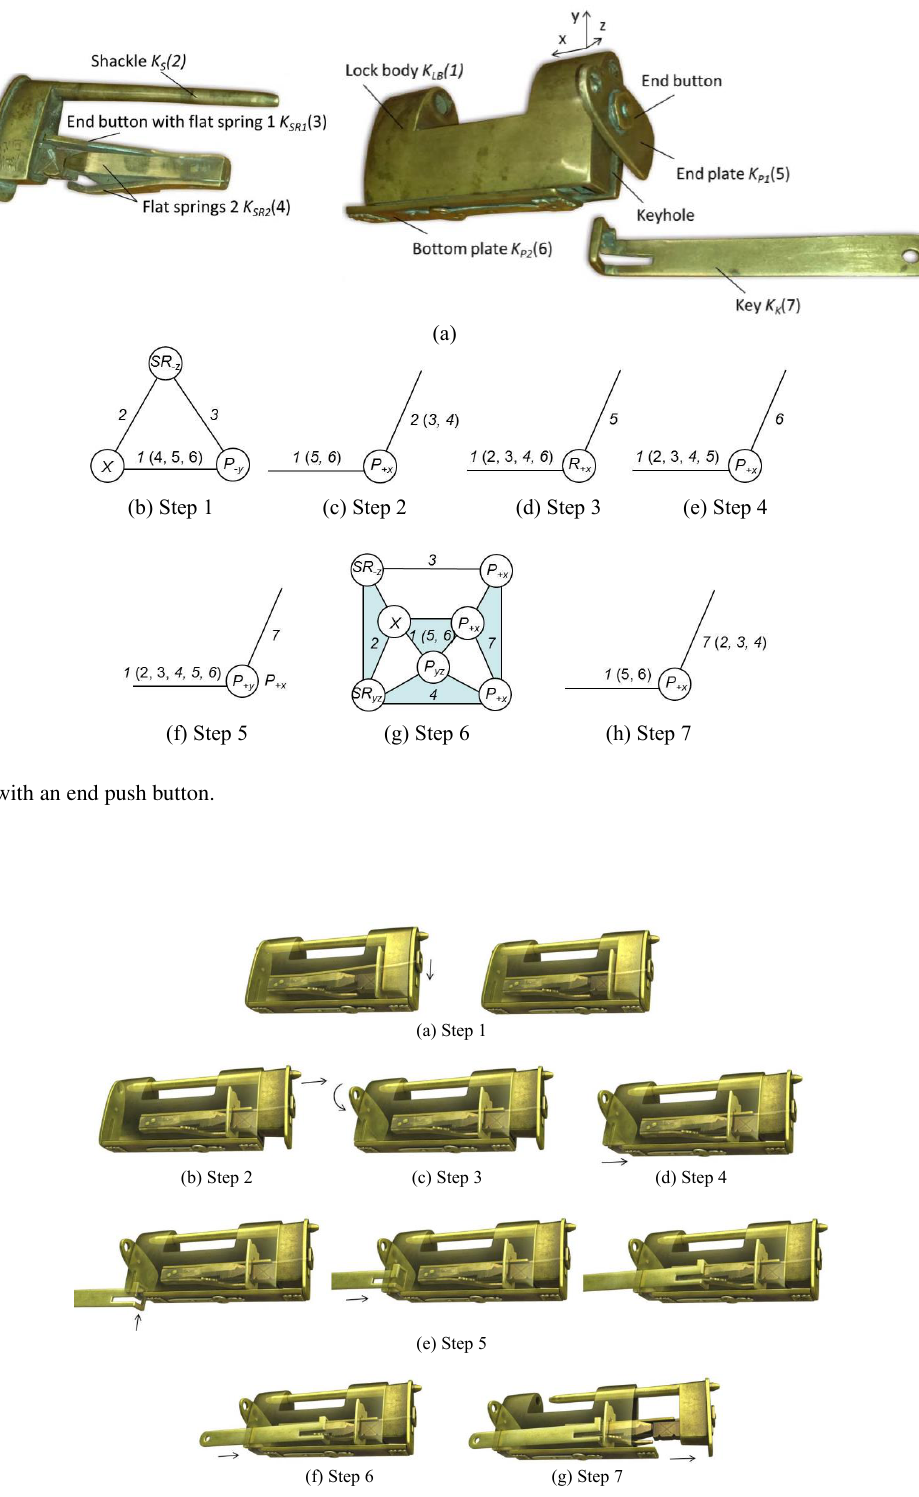
Figure 6. Animation of a padlock with an end push